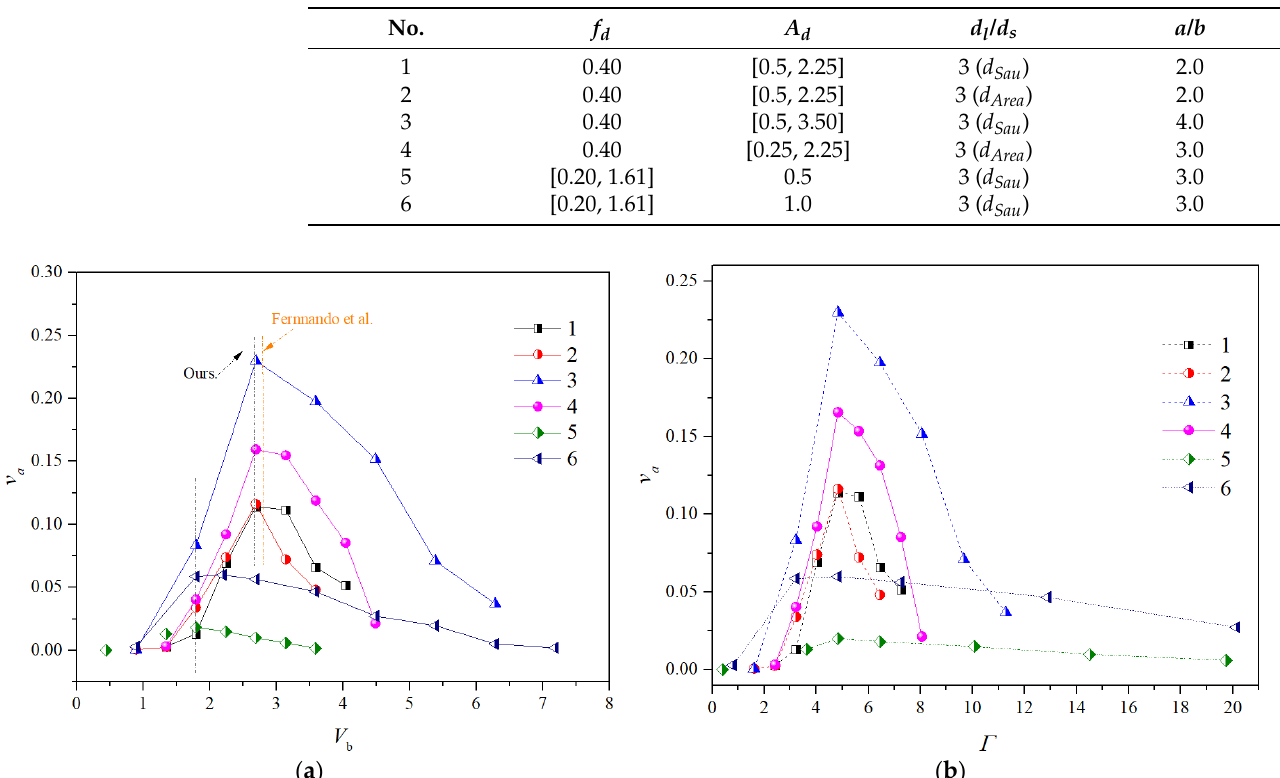
Figure 11. Response of v a to: ( a ) V b ; ( b ) Γ . The conditions for the curves are listed in Table 4.